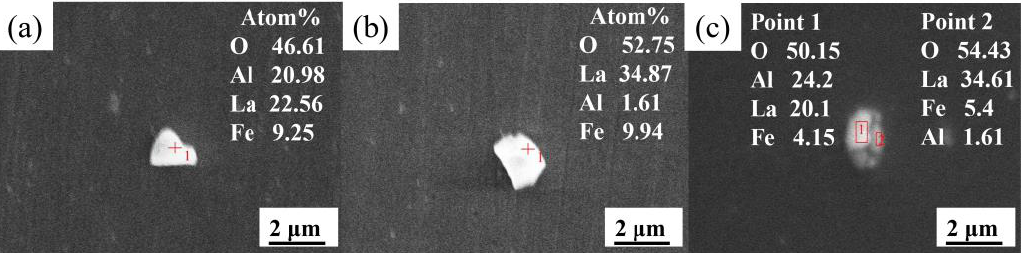
Figure 3. SEM images and EDS results of typical inclusions in steel containing 0.0184 wt.% La: ( a ) LaAlO 3 , ( b ) La 2 O 3 , and ( c ) LaAlO 3 -La 2 O 3 complex inclusion.